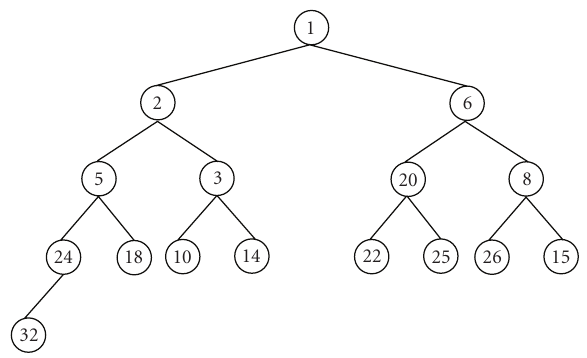
Figure 15: A heap with an increasing